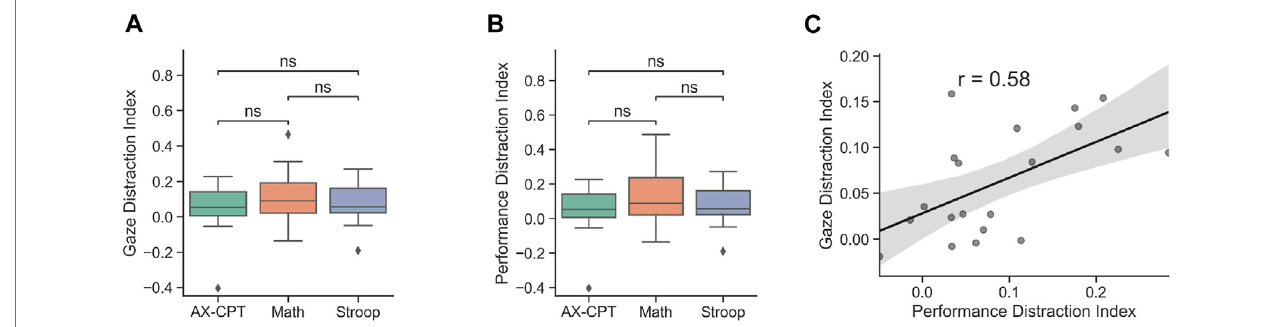
FIGURE 6 | Eye gaze by Task Performance. (A) Gaze distraction index by task. (B) Performance distraction index by task. (C) Correlation between gaze and performance distraction indices (r(19) = 0.58, p <